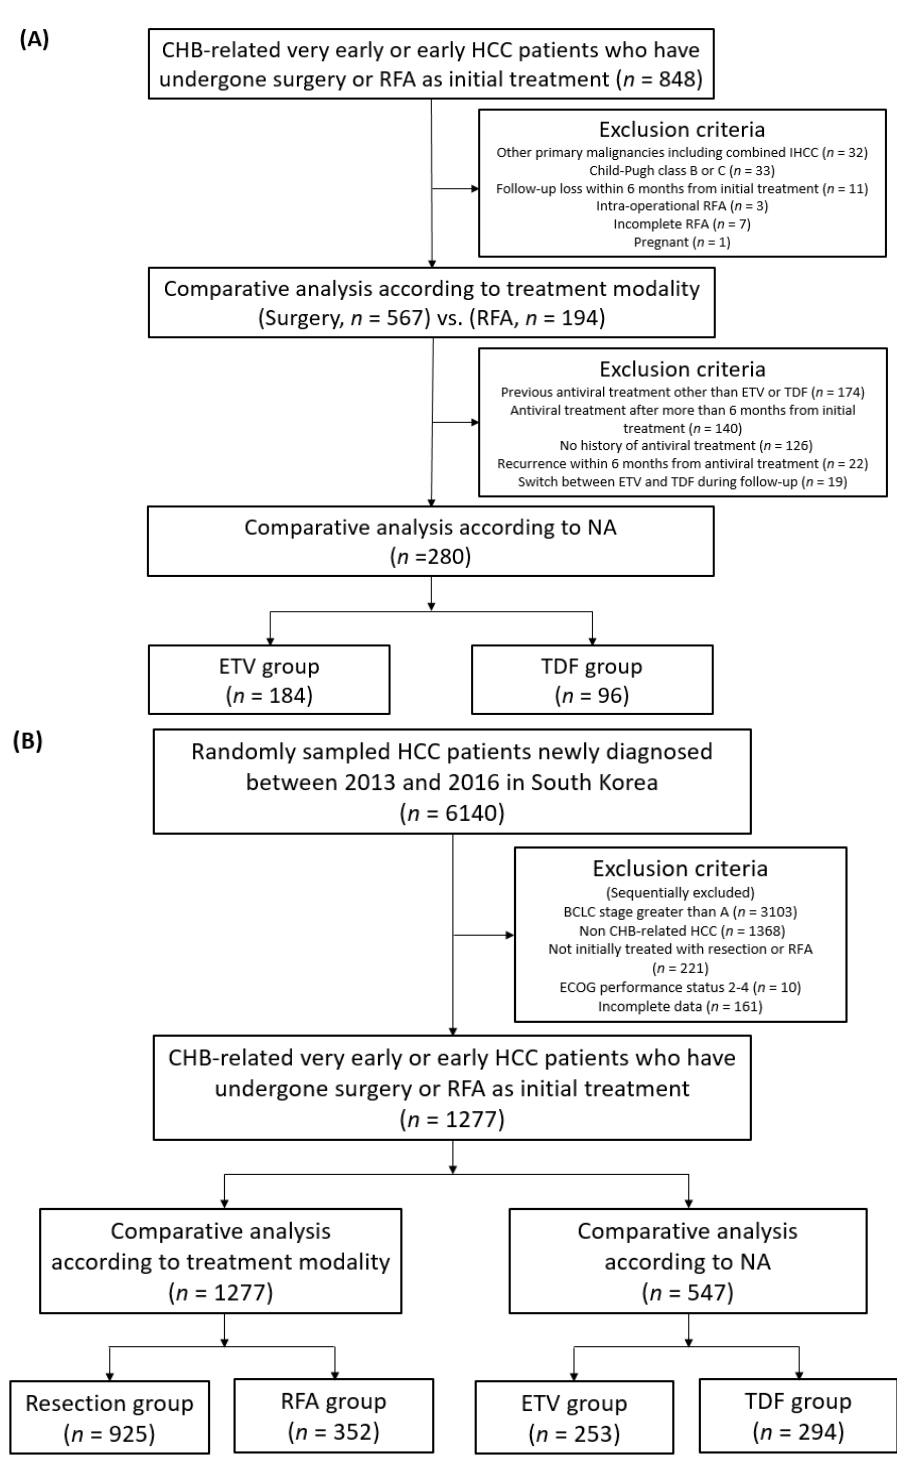
Figure 1. Flow diagram for ( A ) the hospital cohort and ( B ) the nationwide cohort. CHB, chronic hepatitis B; HCC, hepatocellular carcinoma; RFA, radiofrequency ablation; NA, nucleos(t)ide analogue; ETV, entecavir; TDF, tenofovir disoproxil fumarate; IHCC, intrahepatic cholangiocarcinoma; BCLC, Barcelona Clinic Liver Cancer; ECOG, European Cooperative Oncology Group.